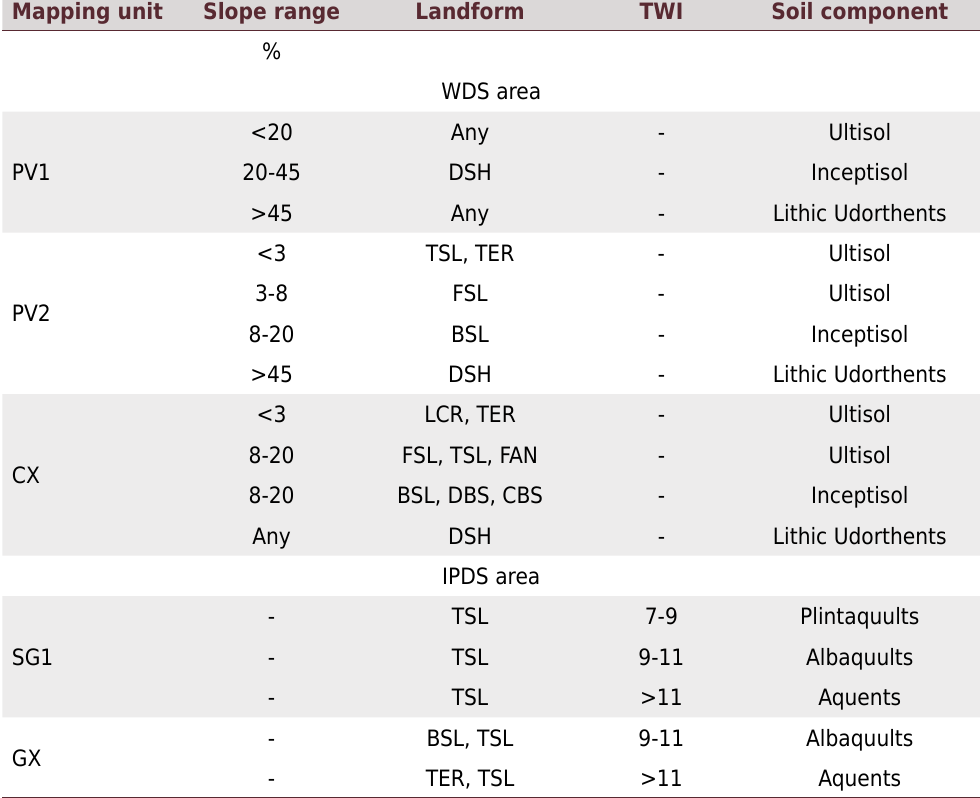
DSH = divergent shoulder; TSL = toe slope; TER = terrace; FSL = foot slope; BSL = back slope; LCR = level crest; FAN = lower slope fan; DBS = divergent back slope; CBS = convergent back slope; Any = any of the landforms; - = not applicable to this